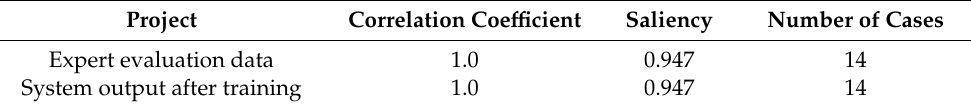
Table 7. Results of the correlation analysis.